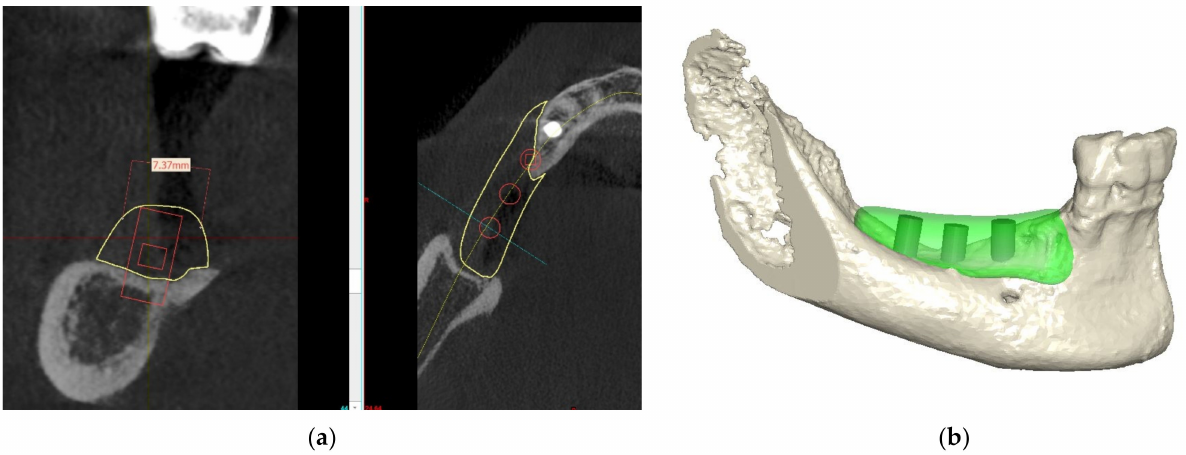
Figure 4. ( a , b ) Bone block